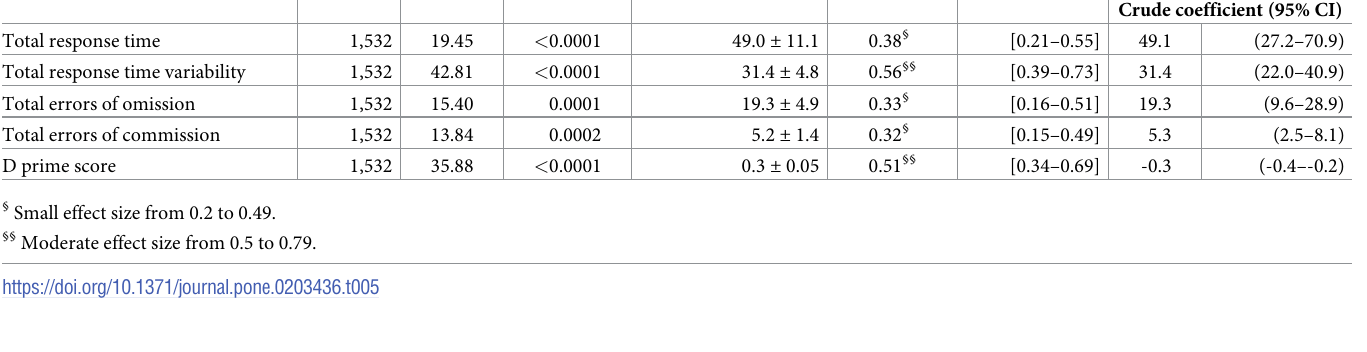
Table 5. Effect size and bivariate analysis between schooling and TOVA measures of children from the PROMISE Saving Brains study in rural Burkina Faso.